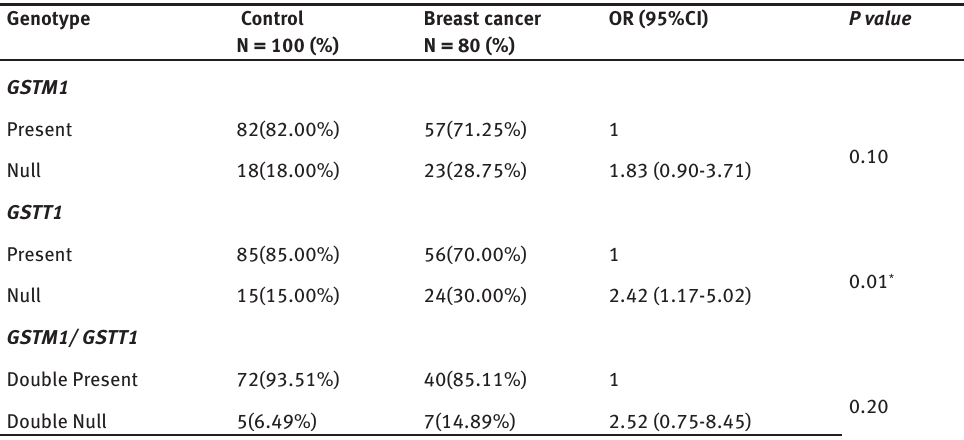
Table 2 : ORs for GSTM1 and GSTT1 breast cancer.